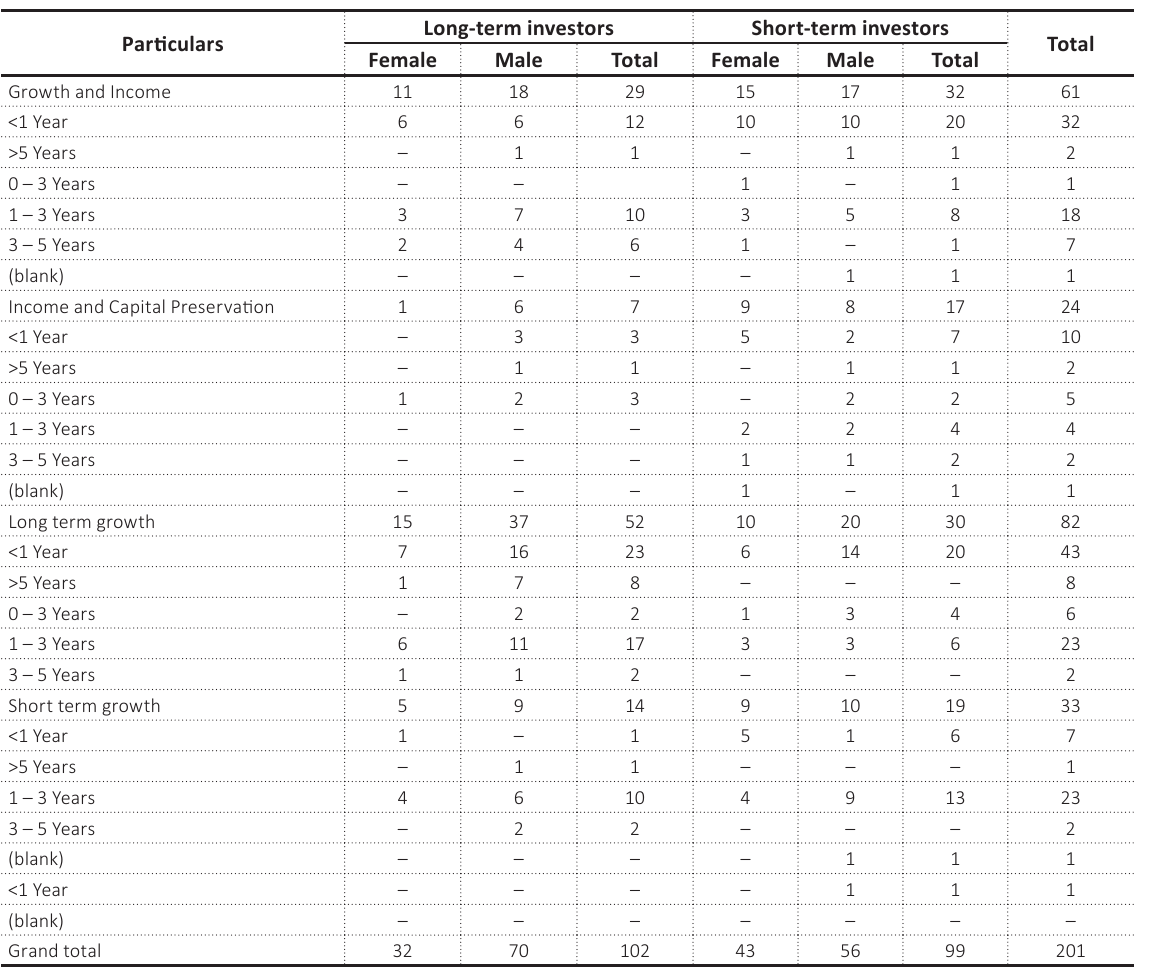
Table A2. Classification of investors based on growth